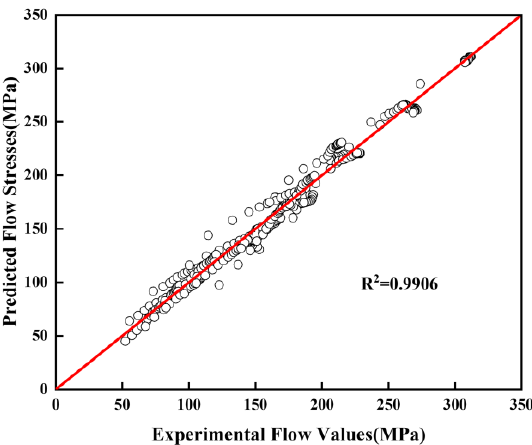
Figure 7. Correlation between predicted values and experimental values over a temperature range of 1173–1373 K with strain rate of 0.01–10 s −1 .